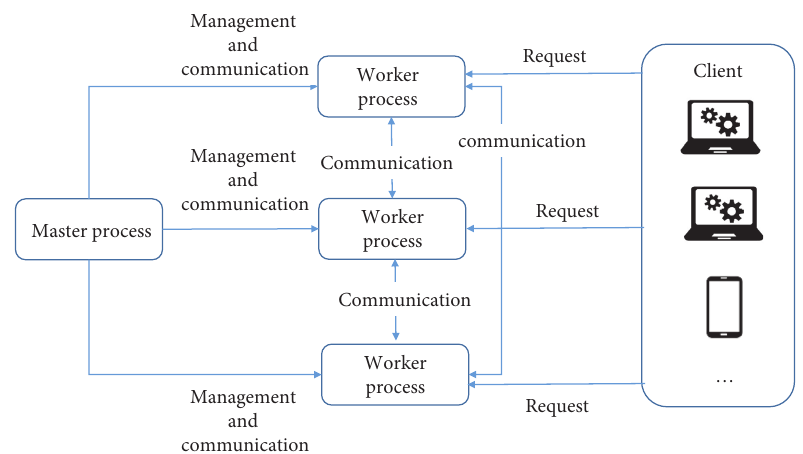
Figure 2: Relationships between master process and worker